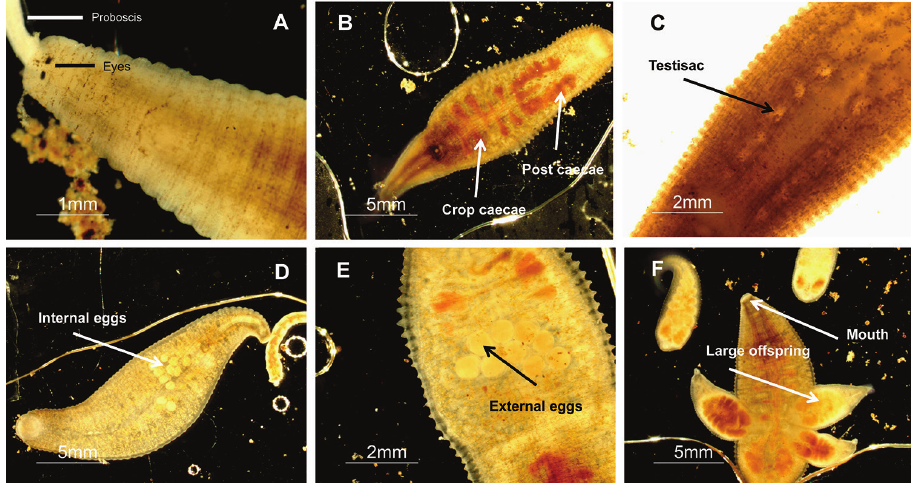
Figure 2. Internal and external morphology of Helobdella blinni sp. n . A dorsal view of the eyes and extended proboscis B crop and post caecae C testisacs D ventral view of internal eggs which have not been oviposited yet E ventral view of white eggs that have been oviposited F ventral view of attached and detached Table 2. Holotype and paratype collection data and voucher numbers.